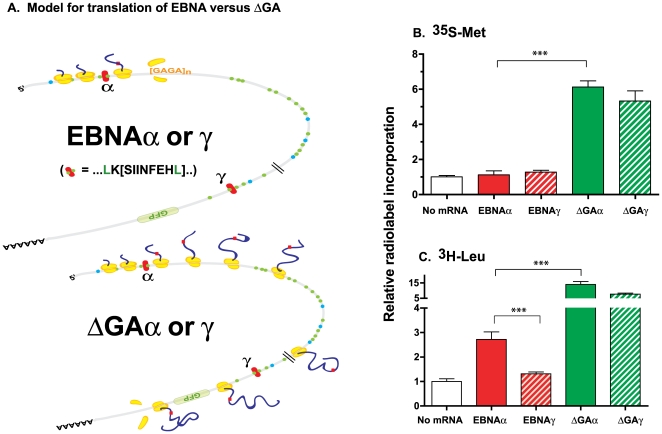
Ribosomes prematurely terminate translation within the 5′ region of EBNA mRNA.(A) Schematic model to account for relative differences in the translational efficiency of EBNA or ΔGA mRNAs. The ribosomes initiate translation at the AUG codon (5′ blue dot) of either EBNA or ΔGA mRNAs. However, translation is terminated within or close to the GAr region shown as [GAGA]n in the EBNA mRNA. The methionine and leucine codons are indicated as blue or green dots respectively. The inserted SHL8 nucleotides, at either the N-terminal “α” or the C-terminal “γ” positions are shown as a red rectangle. All constructs included the indicated in-frame green fluorescent protein (GFP) sequence. (B) The mRNA coding for EBNAα, ΔGAα, EBNAγ or ΔGAγ were translated in vitro in the presence of 35S-Met or 3H-Leu for 1 h. Translation products were precipitated with trichloroacetic acid and collected by filtration. Radioactivity measured by liquid scintillation is shown as relative counts per minute compared to no mRNA control. Bars are average of 5 different experiments (± standard deviation). Standard t-test was used to calculate statistically significant differences shown as asterisks (***: p<0.001).